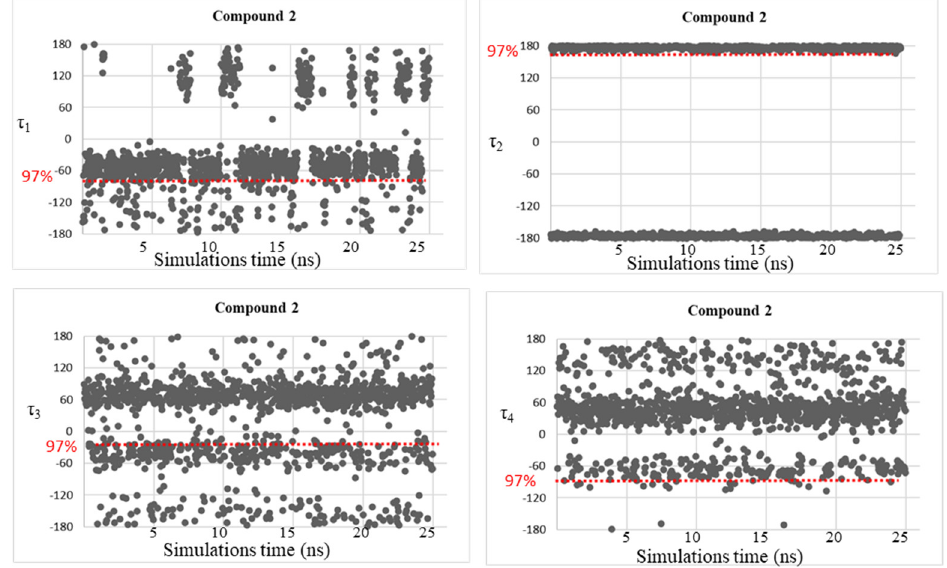
Figure 6. Dihedral torsion angle values τ 1 , τ 2 , τ 3 , and τ 4 of compound 2 over the MD simulations. The red dotted line highlights the torsional angles values found by DFT calculations in the most populated energy minima. The red label on the left displays the corresponding population percent- age.